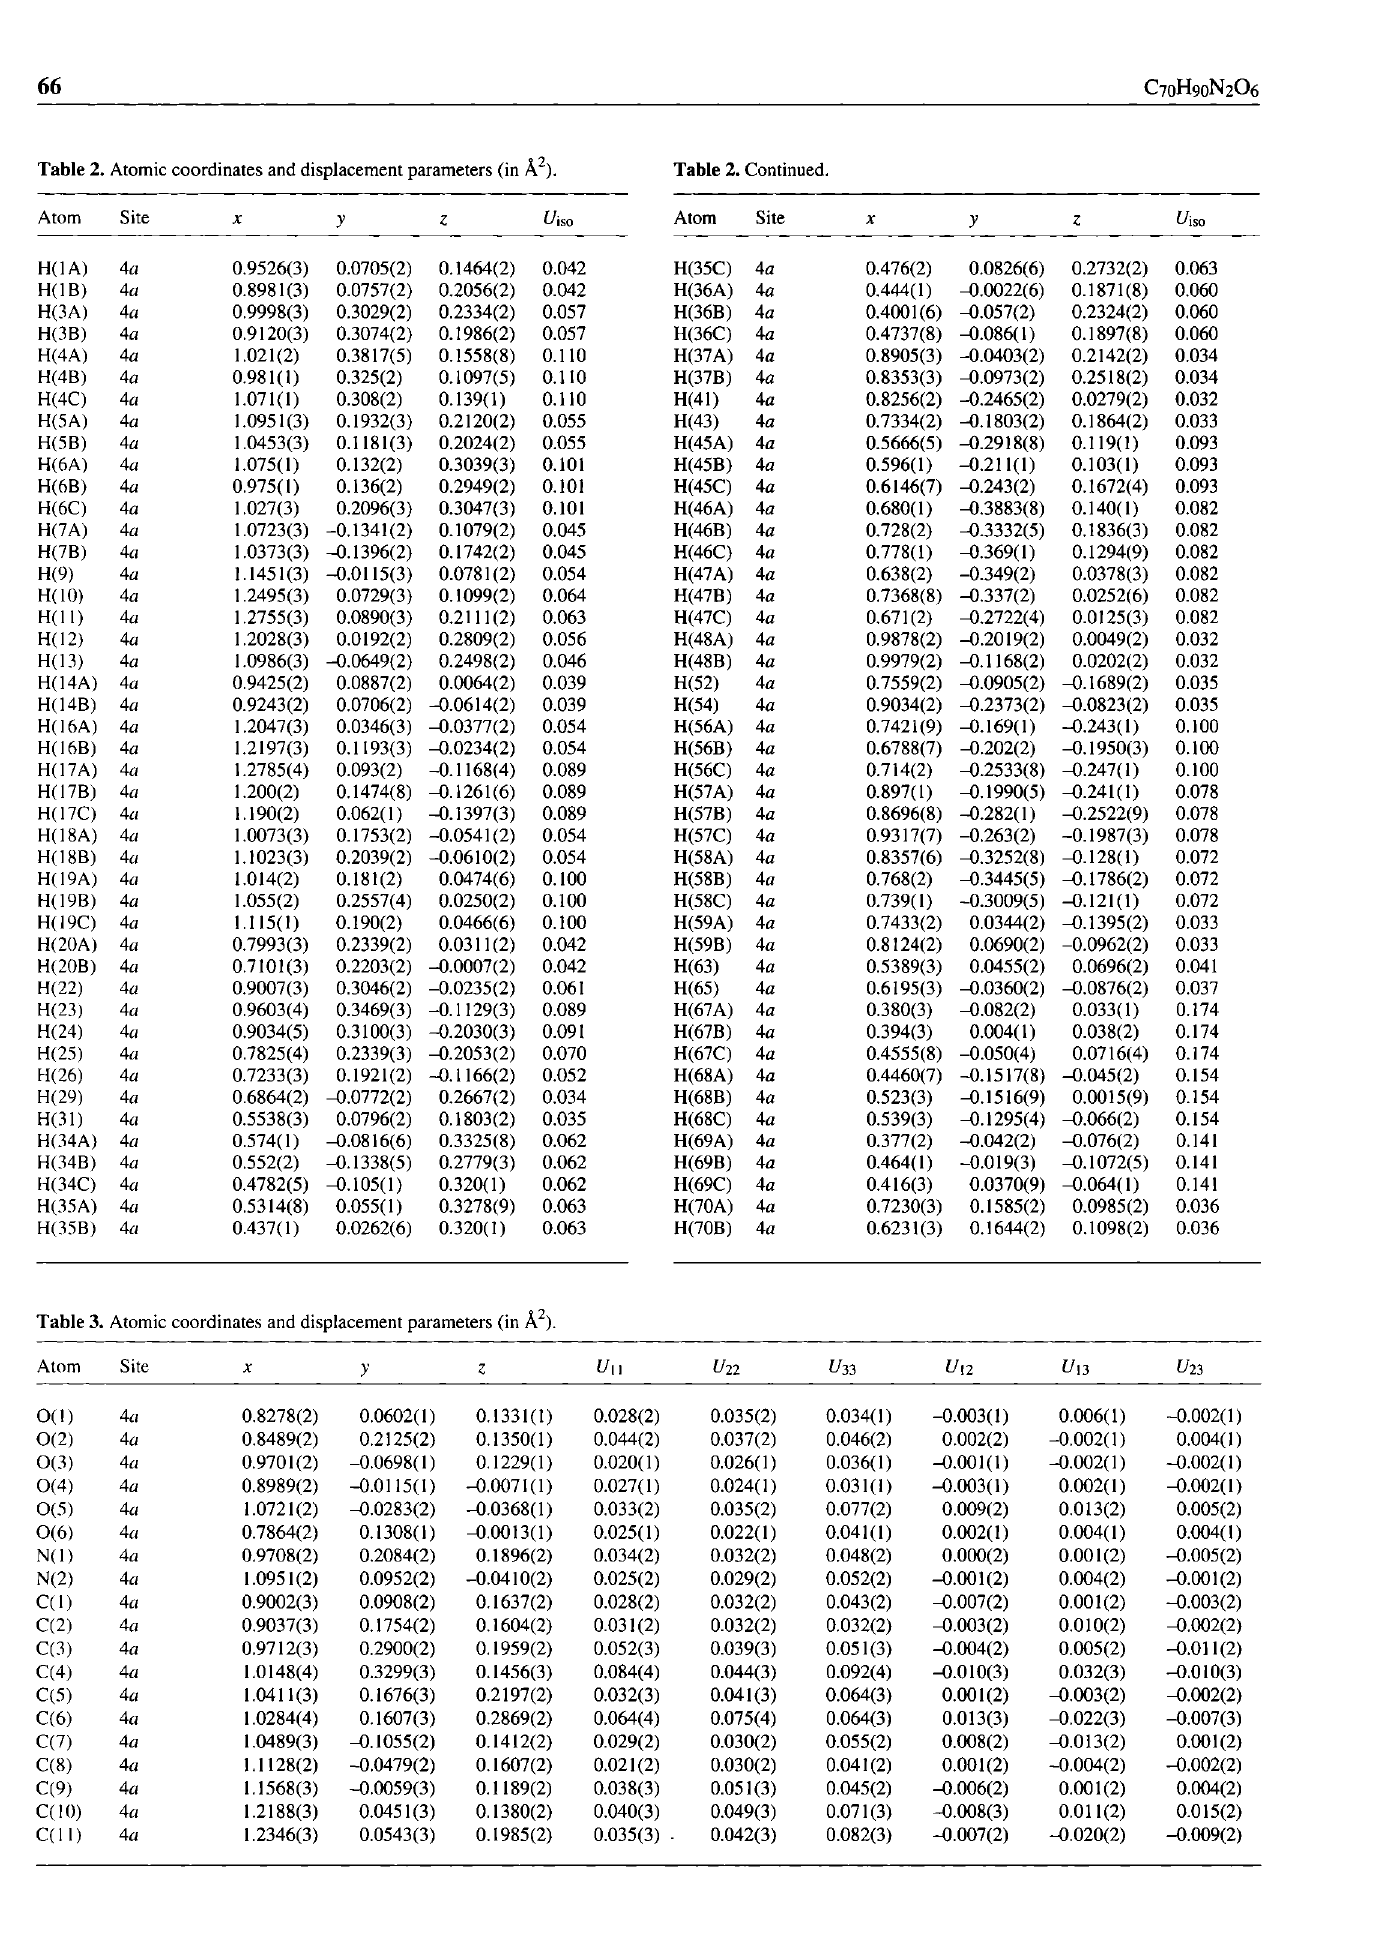
Table 2. Atomic coordinates and displacement parameters (in Ä 2 ).